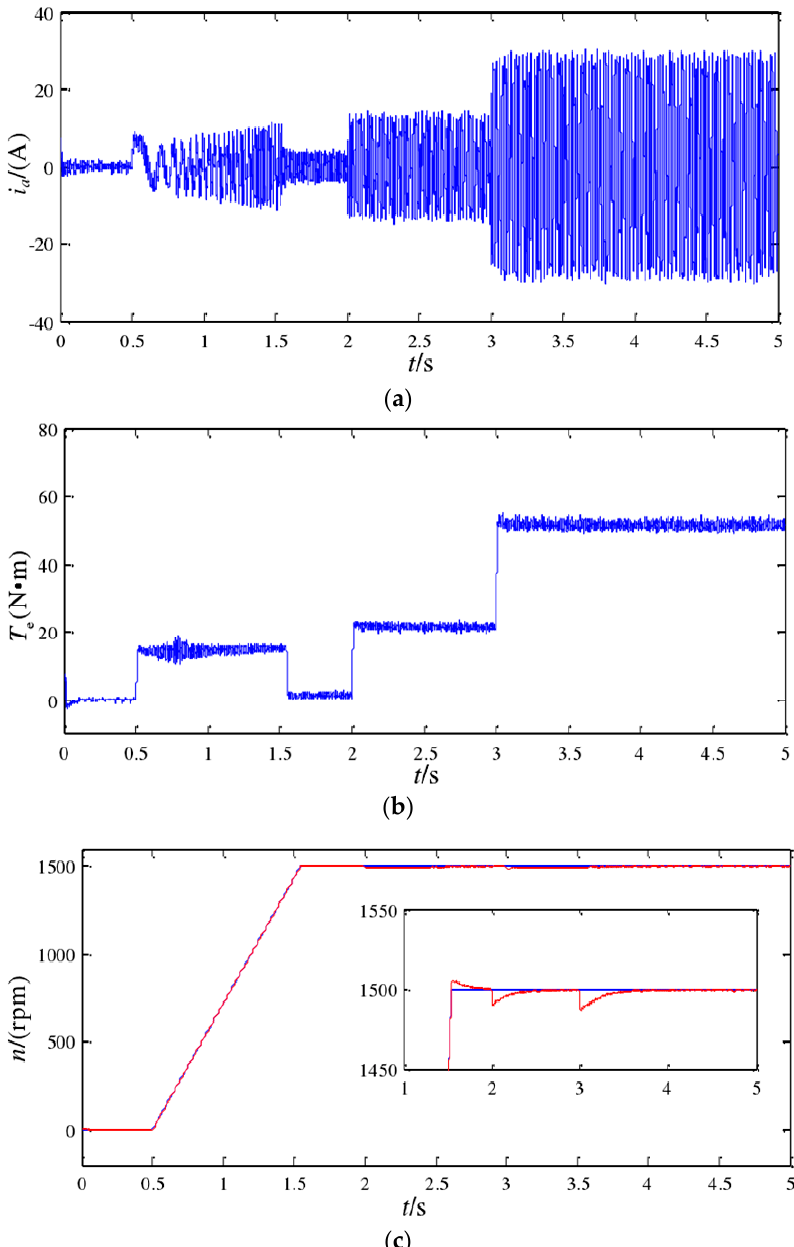
Figure 14. Simulation waveform of bilinear transformation method: ( a ) a phase stator current wave-